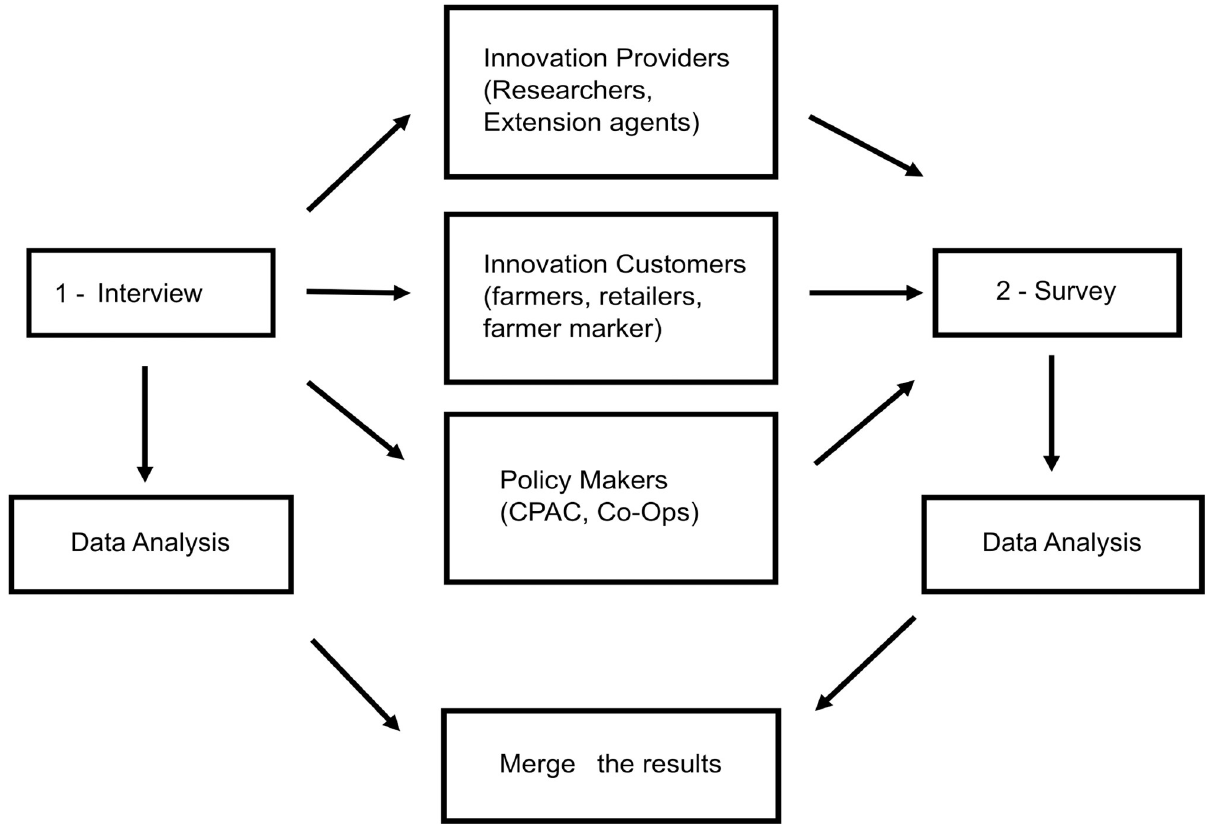
Fig 3. Experimental design to collect and analyze qualitative and quantitative data. The first step in the procedure was interviews, which we analyzed and used to generate the survey as the second step. Data from both the interview and the survey were merged for subsequent